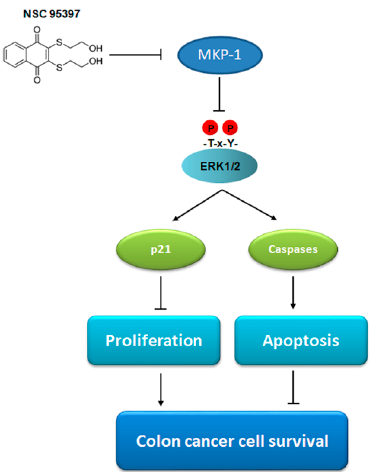
Figure 6. A schematic showing that the cytotoxic effect of NSC 95397 on colon cancer cells is activated by inhibiting MKP-1 activity followed by ERK1/2 activation. Lines ending in arrows indicate promotion and T-bars represent inhibition.